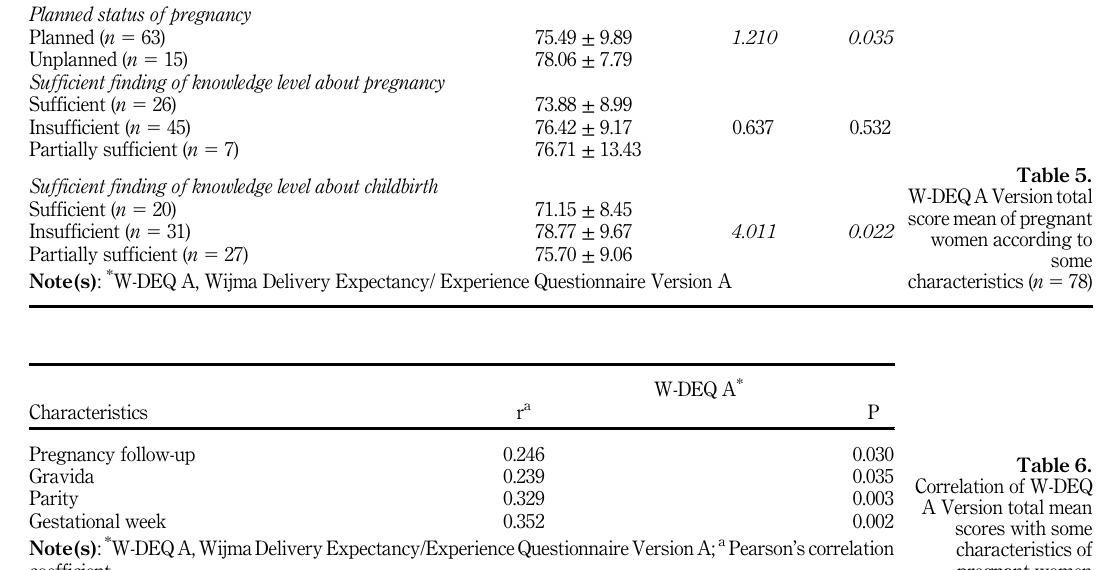
Table 6. Correlation of